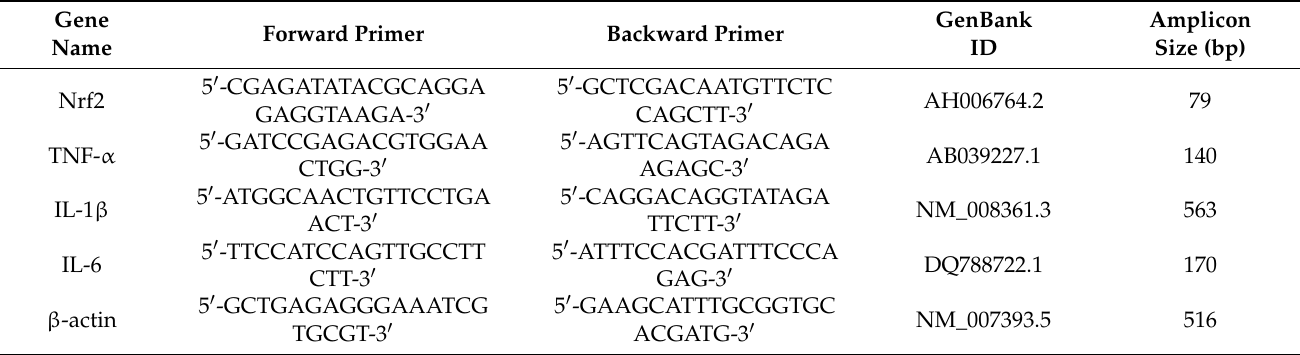
Table 1. Primer sequences for amplifying specific